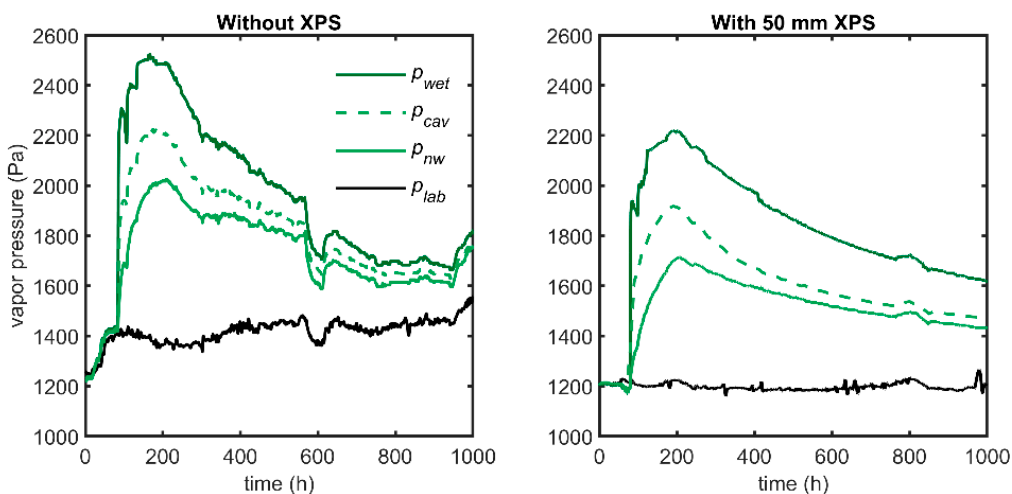
Figure 7. Vapor pressures in the wetted OSB region ( p wet ), in OSB outside the wetted region ( p nw ), and in cavity air ( p cav ) compared to laboratory ( p lab ).